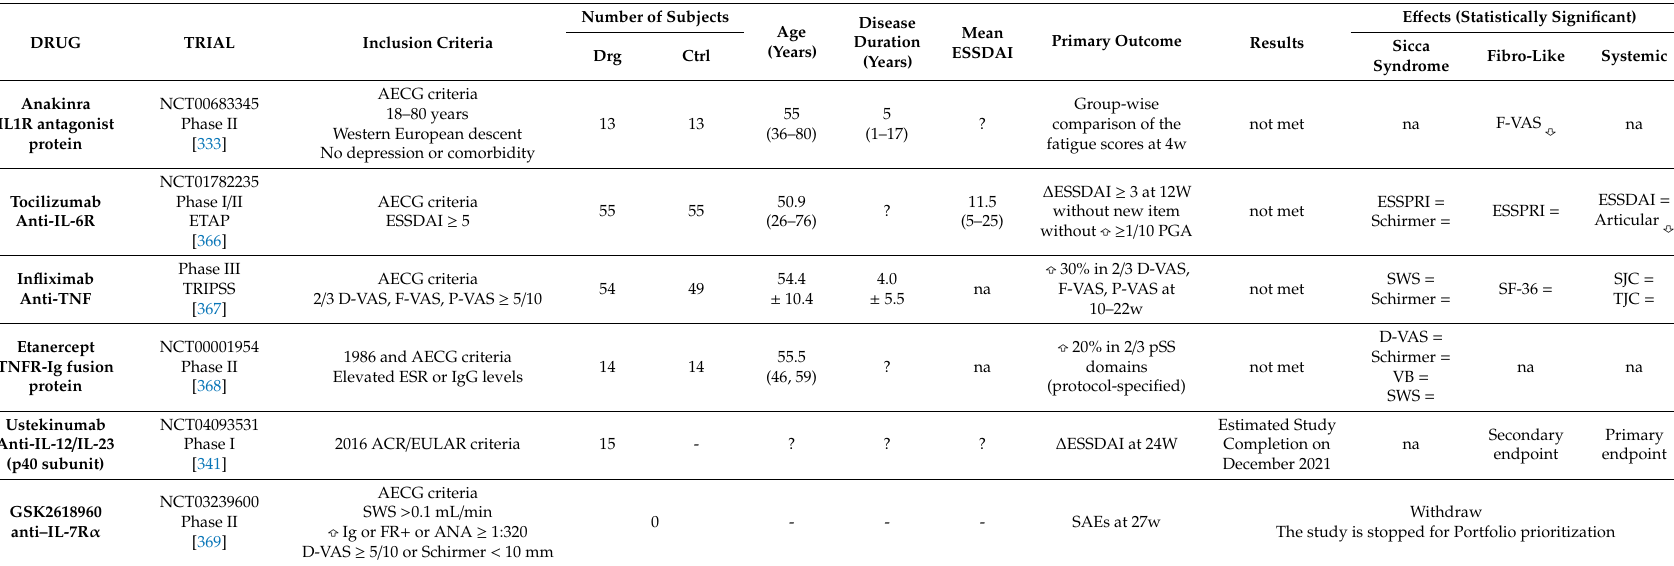
Table 11. Anti-cytokine targeted drugs in